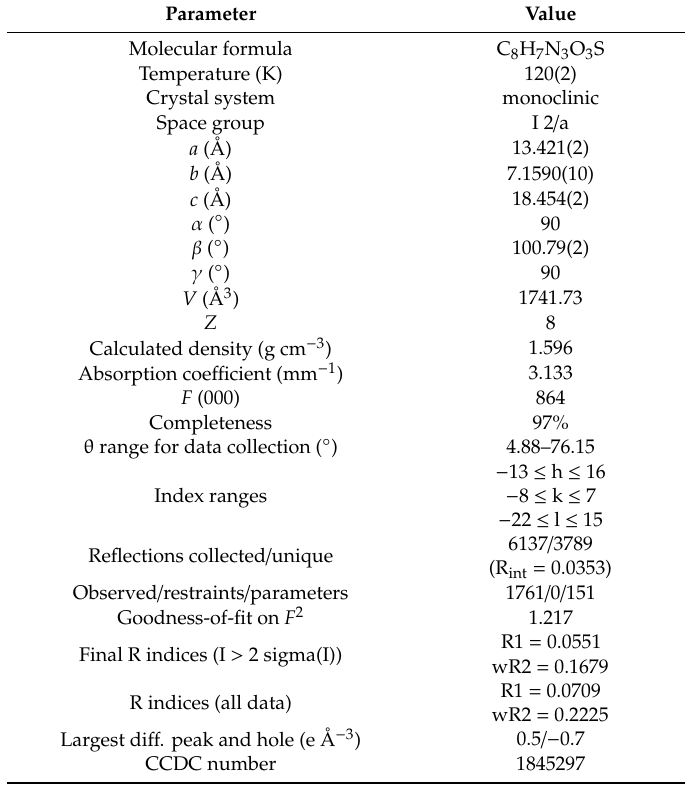
Table 3. Crystallographic parameters and details of refinement for the measured crystal of compound 1 . The labels are related to the Figure